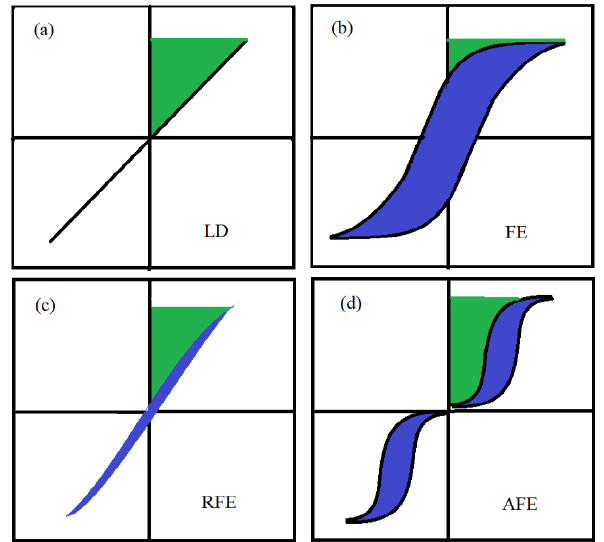
Figure 1. Hysteresis and corresponding energy storage density for ( a ) linear dielectrics, ( b ) ferroelectrics, ( c ) relaxor ferroelectrics, and ( d ) antiferroelectrics. The green area represents energy density and the blue area refers to the energy loss.